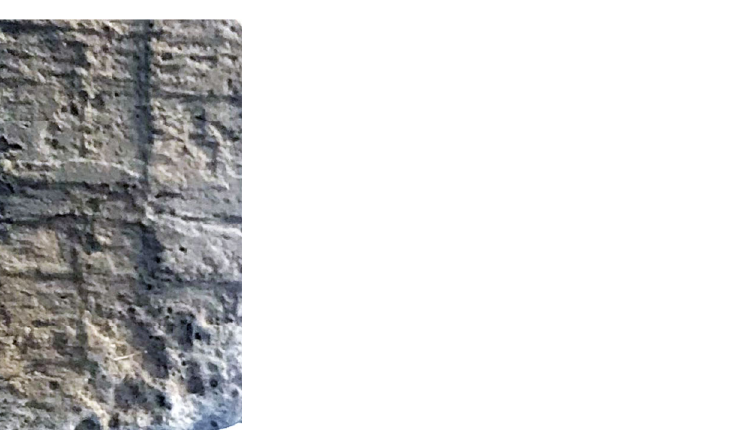
Figure 15. Lime/gypsum mortar taken from house-fort of Cap de Forma. Detail of geometric texture on the external surface of the sample, probably made with an intertwining of reed fibres (reed, perhaps positioned below and “visible”).